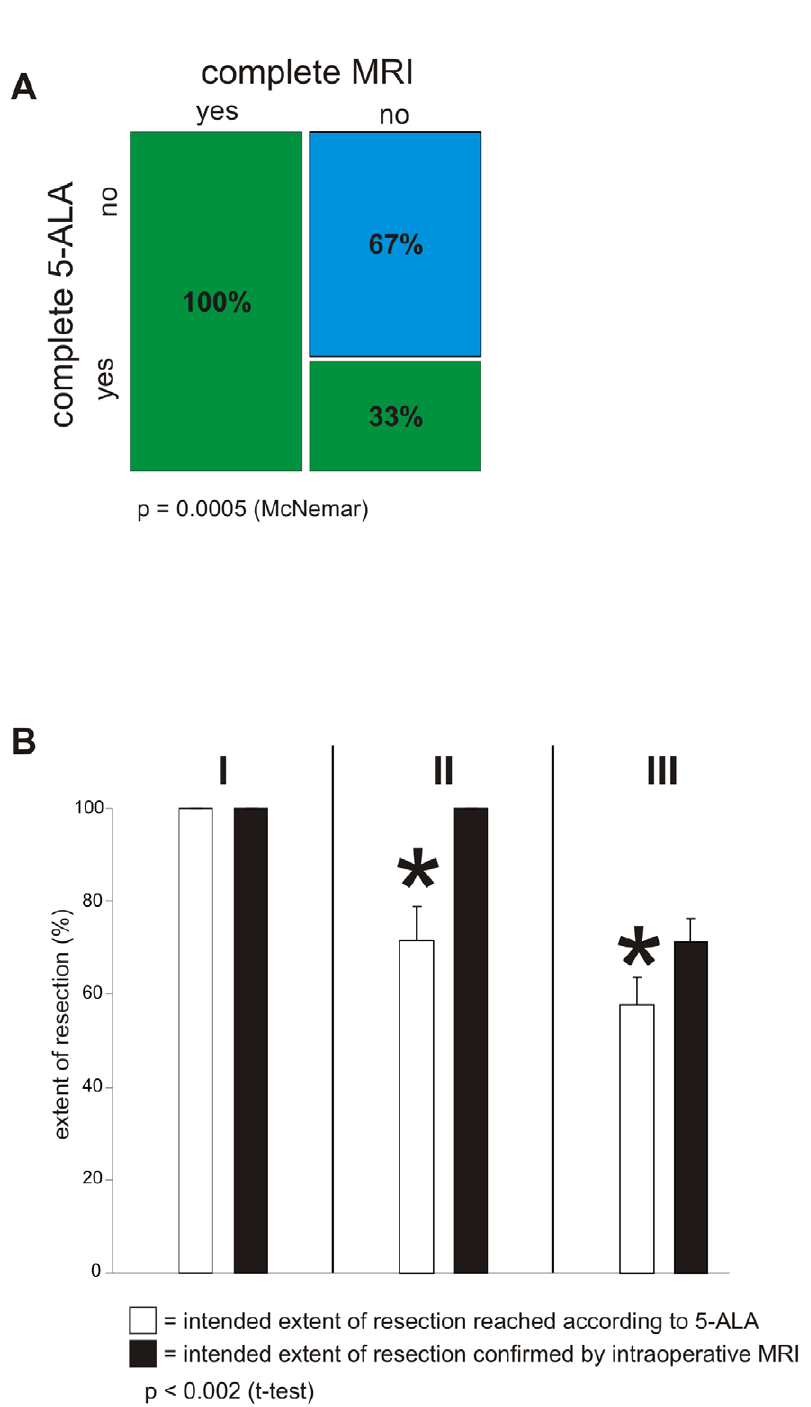
Figure 5. Dual intraoperative visualization approach in different functional grade patients. A, Extent of resection was determined by 5- ALA and the results verified through iMRI. This was defined as one sequence of the procedure. 21 sequences showing complete resection according to 5-ALA were confirmed by iMRI (complete 5-ALA: yes, complete MRI: yes – green bar, first column). 14 sequences showing complete resection according to 5-ALA could not be confirmed by iMRI, which detected residual tumor (complete 5-ALA: yes, complete MRI: no – green bar, second column). 29 sequences showed residual tumor both according to 5-ALA as well as iMRI (complete 5-ALA: no, complete MRI: no – blue bar, second column). The order of these sequences resulted in a p-value=0.0005 (McNemar). B, Functional tumor localization was categorized according to Sawaya [20]. Tumors in non-eloquent areas were defined as functional grade I [marked with I]. Functional grade II was defined as tumor localization close to an eloquent brain area [marked with II]. Functional grade III (given as III at the top) was defined as tumor localization in an eloquent brain area. Extent of resection was calculated as a percentage of prior tumor volume. Within the subgroup I the intended 100% resection was achieved by surgery with 5-ALA alone. In the subgroup II 5-ALA alone resulted in a tumor resection of 71.7% ( 6 7.285 sem), whereas additional use of iMRI significantly increased tumor resection to 100% (p-value , 0.002; Student’s t-test). The subgroup III showed significant difference in extent of tumor resection. The results of tumor resection were 57.6% ( 6 6.01 sem) achieved with 5-ALA alone, whereas a further tumor resection up to 71.2% ( 6 5.257 sem) could be achieved through the additional use of iMRI. doi:10.1371/journal.pone.0044885.g005 PLOS ONE |